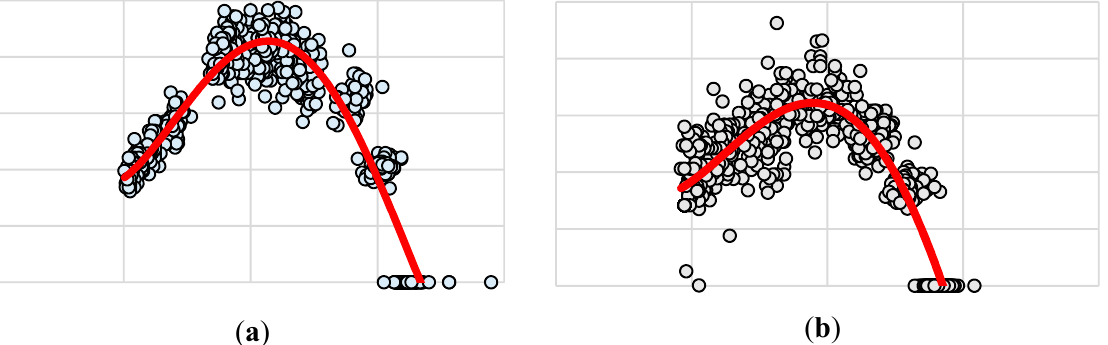
Figure 4. This figure shows the results obtained by the TURTLE System during the two tests carried out for different fluid velocities: ( a ) Cp- λ curve obtained with a fluid speed of 0.63 m/s; ( b ) Cp- λ curve obtained with a fluid speed of 0.539